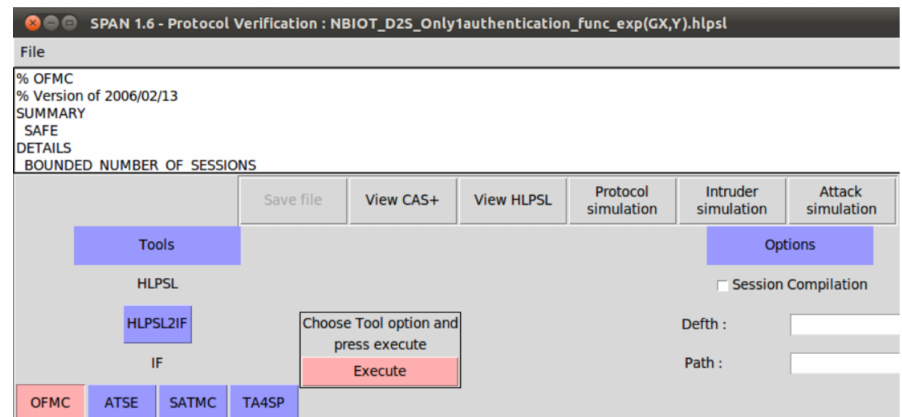
Figure 8. The result of On-the-Fly-Model-Checker (OFMC) on the D2S authentication.